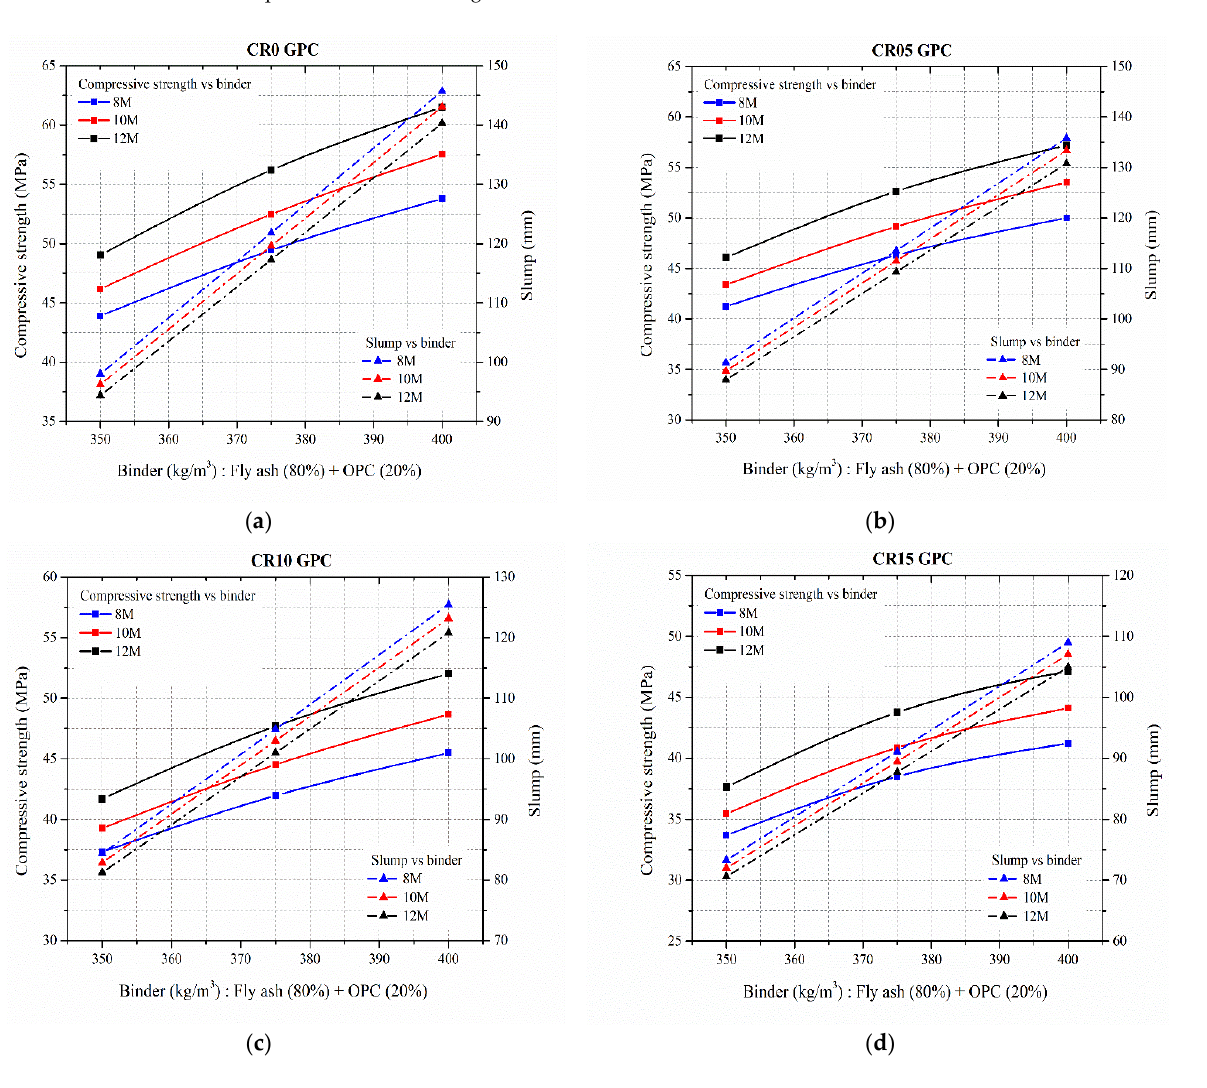
* CR — crumb rubber, C A — coarse aggregates, M — molarity, TAS — total alkaline solution, SP — Su- perplasticizer, all quantities are taken in kg/cubic meters.